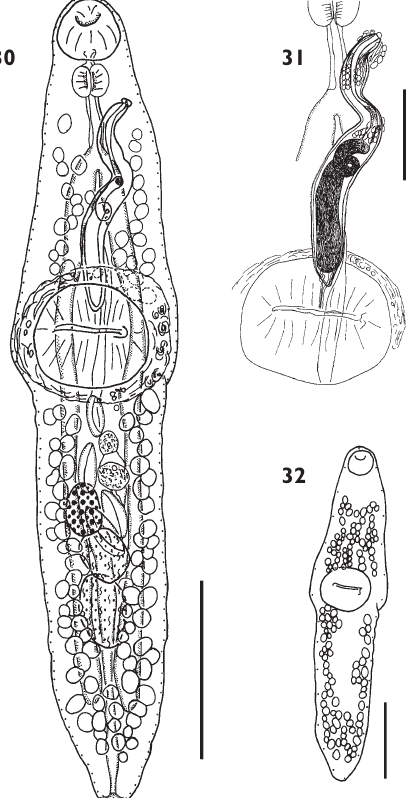
Figs 30-32. Macvicaria heronensis Bray & Cribb, 1989 ex Trachinotus coppingeri . 30. Whole-mount ventral view. 31. Terminal genitalia. 32. Dorsal distribution of vitelline follicles. Scale bars : 30, 32, 250 μm; 31, 100